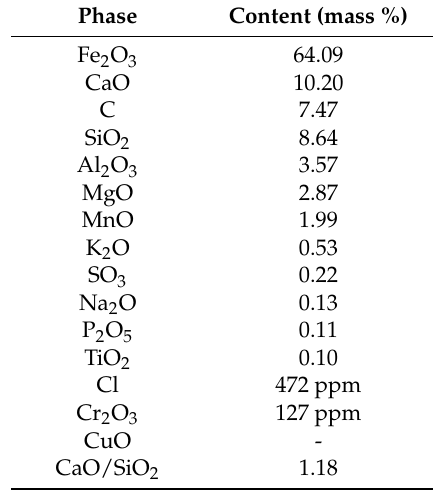
Figure 2. ( a ) Scheme of the experimental device used in the tests, distances in millimeters; ( b ) image of the real conditions, with fumes being released from the sample (thermocouple wire in black, located at an average height of the crucible). Table 1. Chemical composition of the Voestalpine sinter